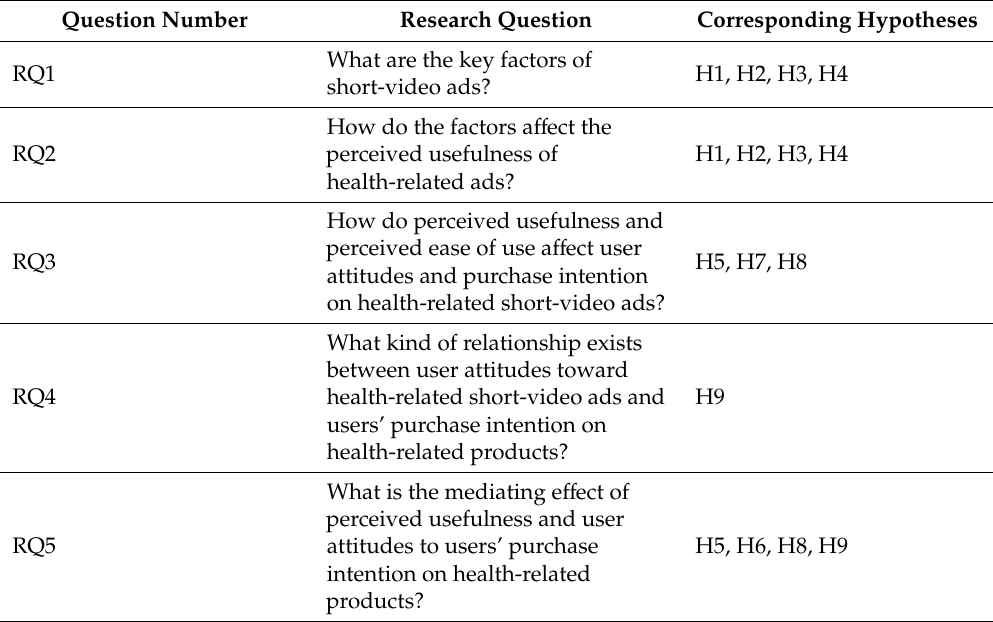
Figure 2. The research model extended from Technology Acceptance Model (TAM) [23] (each rectangle represents one variable. The mediator variables are shaded grey. Purchase intention is the dependent variable, and the remaining five are independent variables). Table 1. Research questions and corresponding